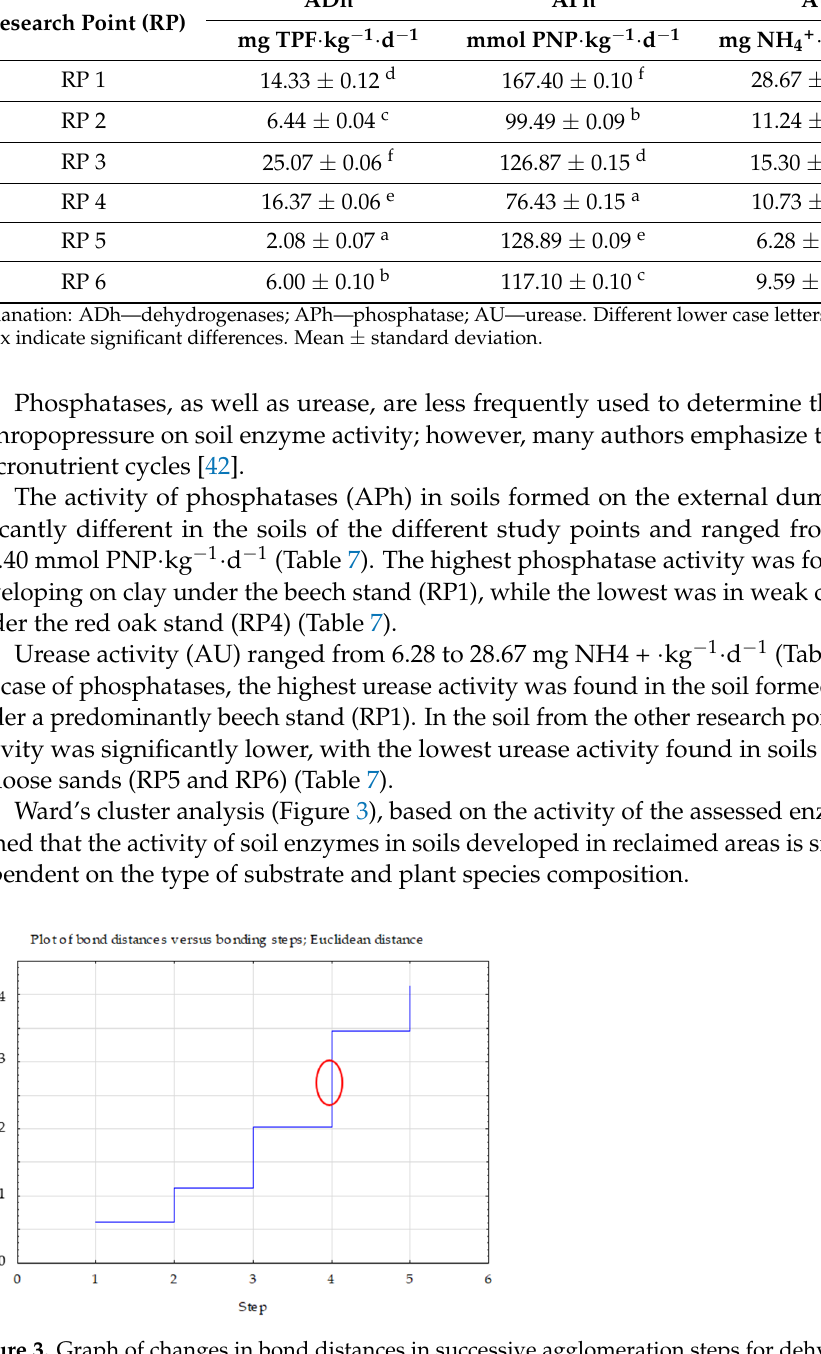
Table 7. Soil enzymatic activity.